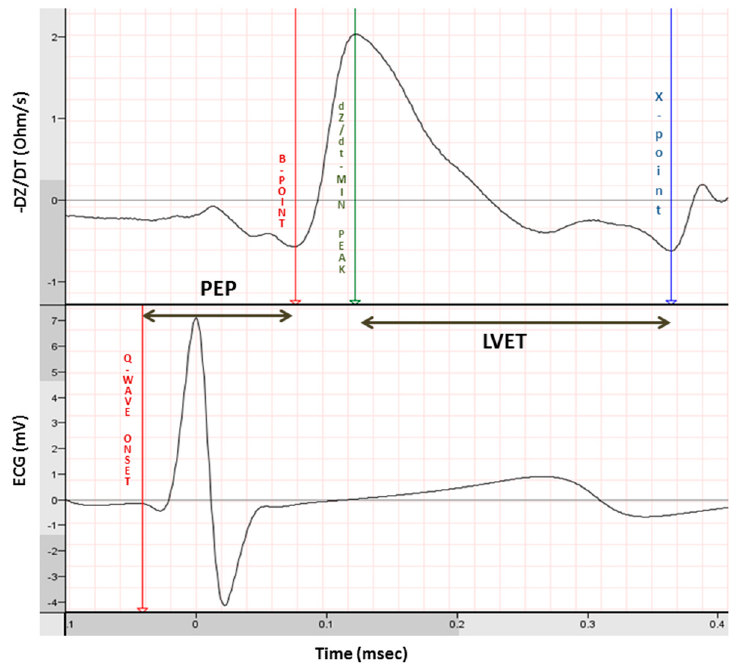
Figure 3. Systolic time intervals including PEP. PEP; pre ejection period. LVET; left ventricular ejection time